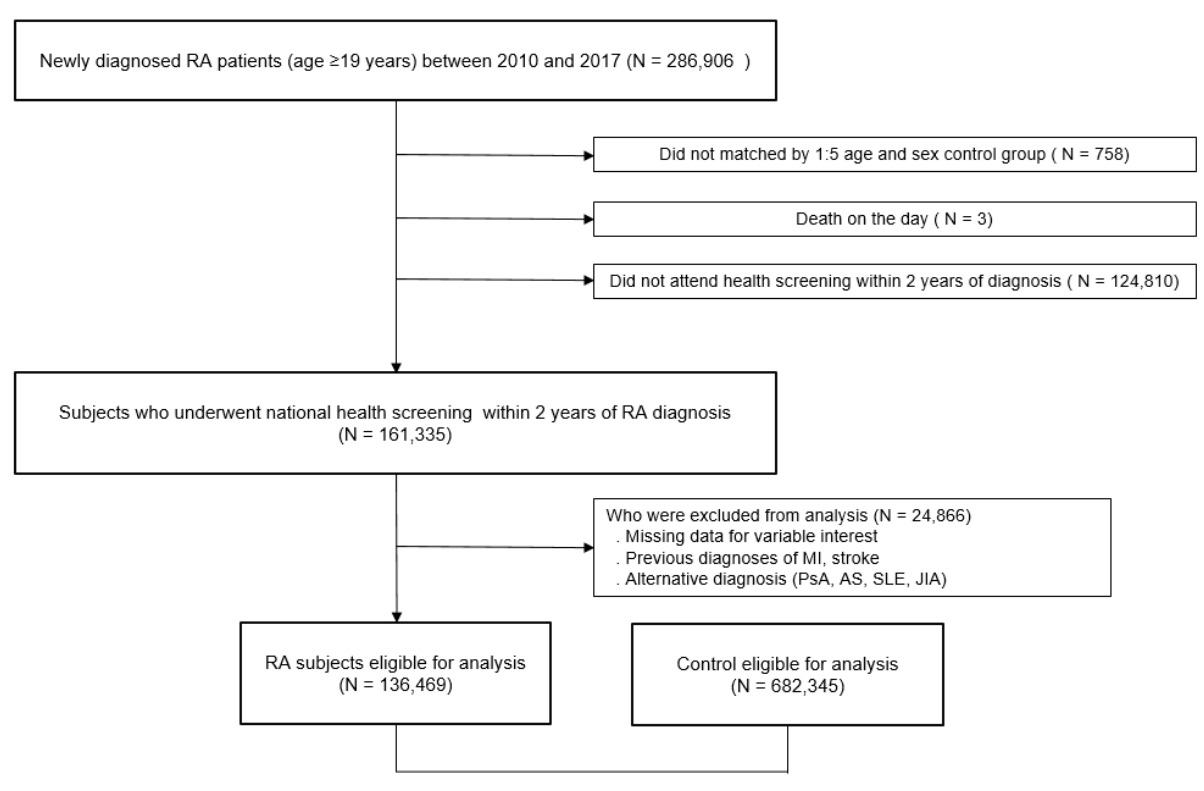
Figure 1. Flowchart of the study population. RA; rheumatoid arthritis. Table 1. Baseline characteristics of the study population.